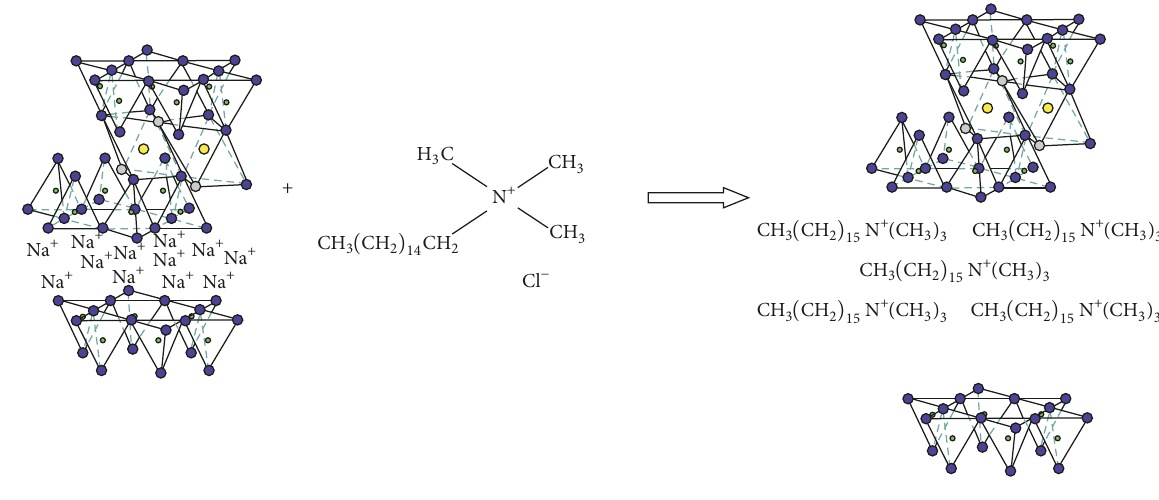
Figure 1: Scheme of organobentonite